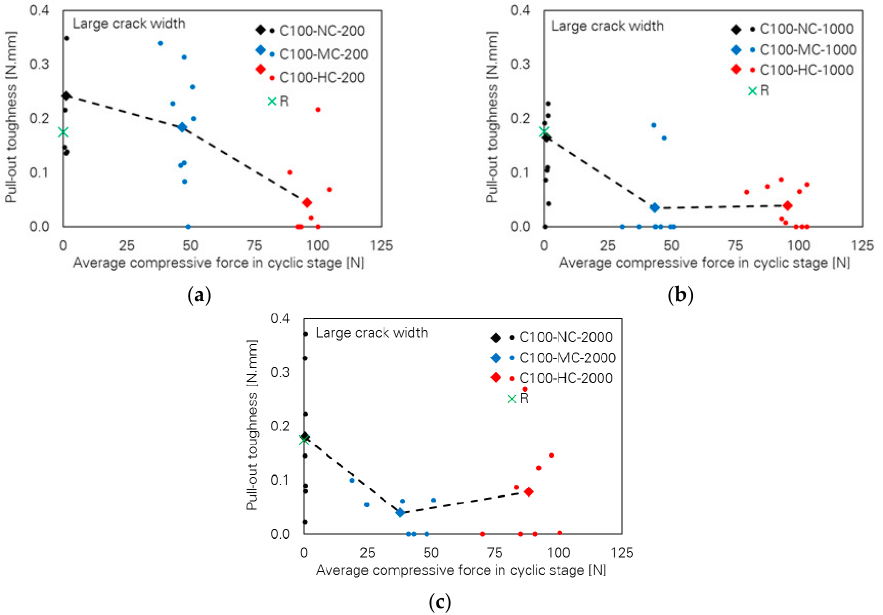
Figure 6. Influence of cyclic compressive force level on pull-out toughness of the specimens with large crack width; number of cycles: ( a ) 200, ( b ) 1000 and ( c ) 2000.